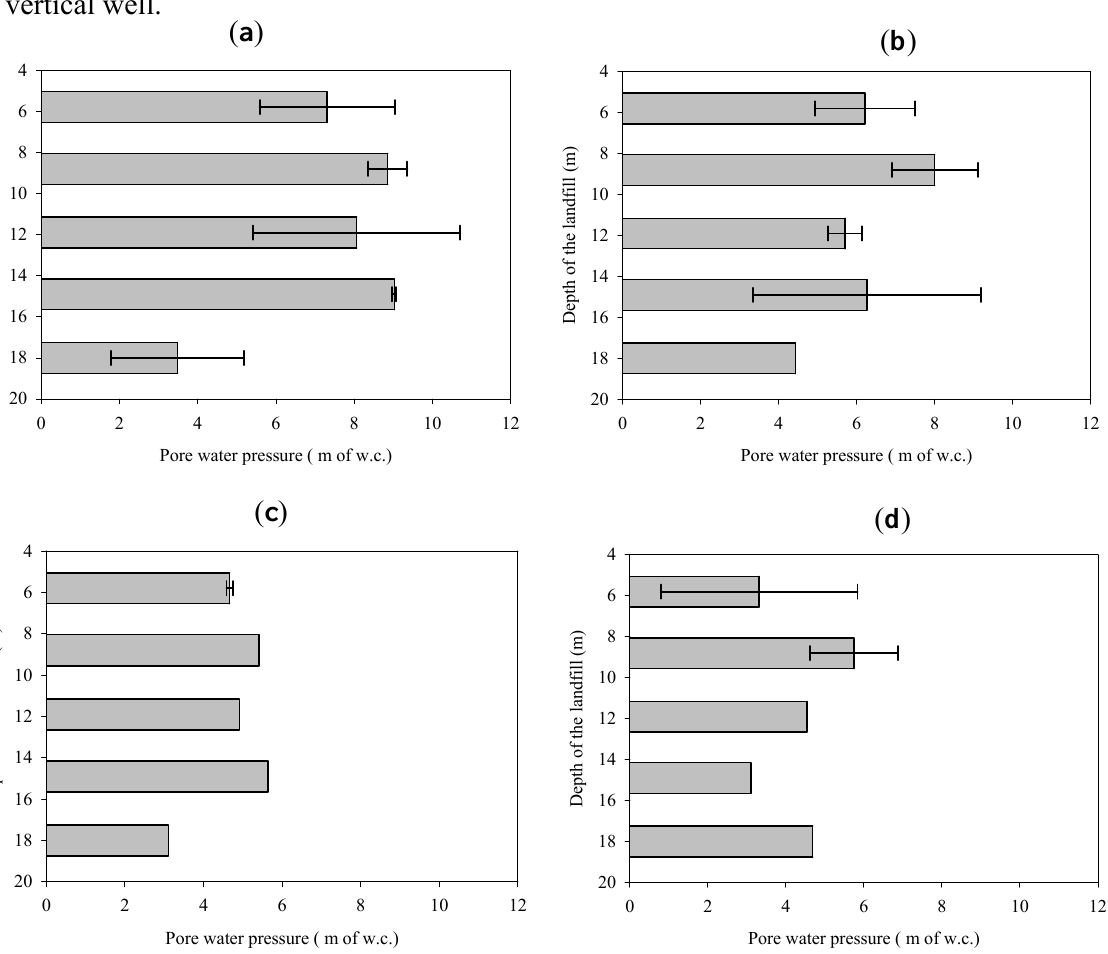
Figure 8. Variation the pore pressures in the waste surrounding Well 2 as a function of depth on day 93 while the leachate was actively added to the well. Error bars indicate one standard deviation of uncertainty. ( a ) A radial distance of 2.15 m from the buried vertical well; ( b ) A radial distance of 3 m from the buried vertical well; ( c ) A radial distance of 6.3 m from the buried vertical well; ( d ) A radial distance of 7.8 m from the buried vertical